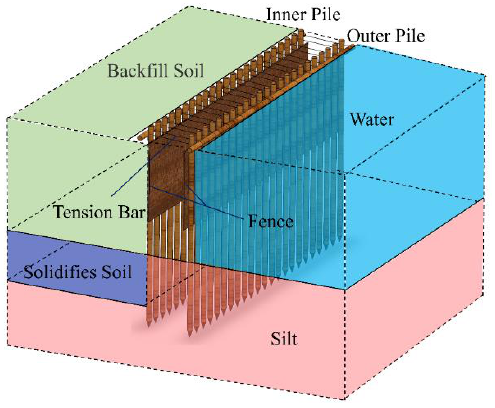
Figure 6. Double row wood pile structure.